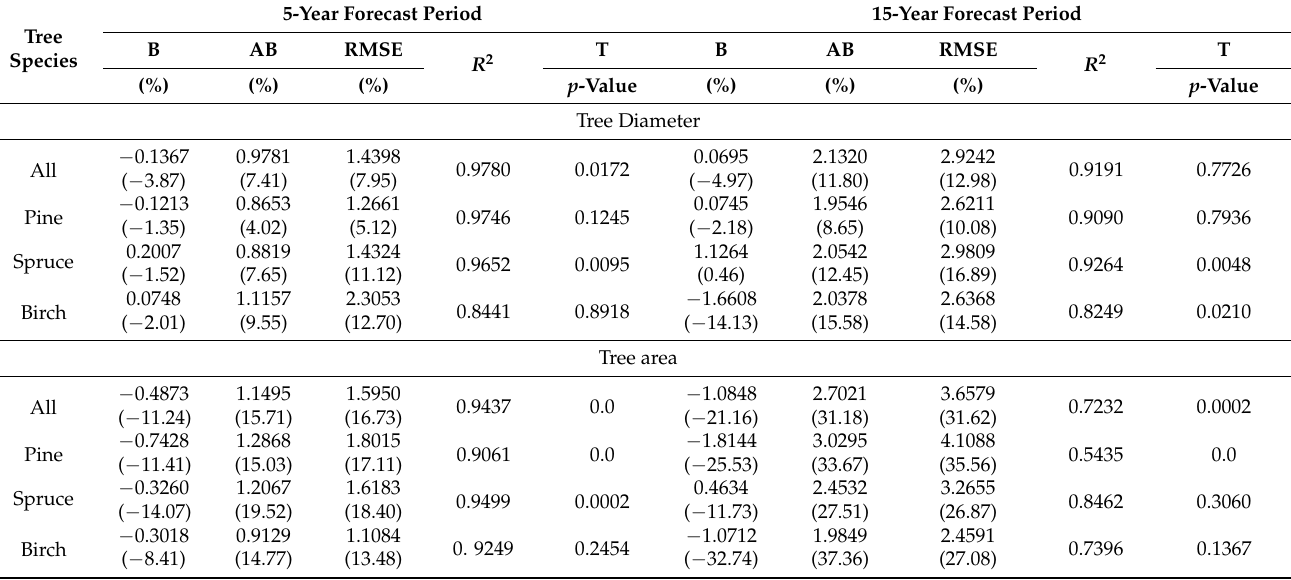
Table 5. Statistical measures and p -values of the Student’s t -test for the forecasts of the individual-tree scenario